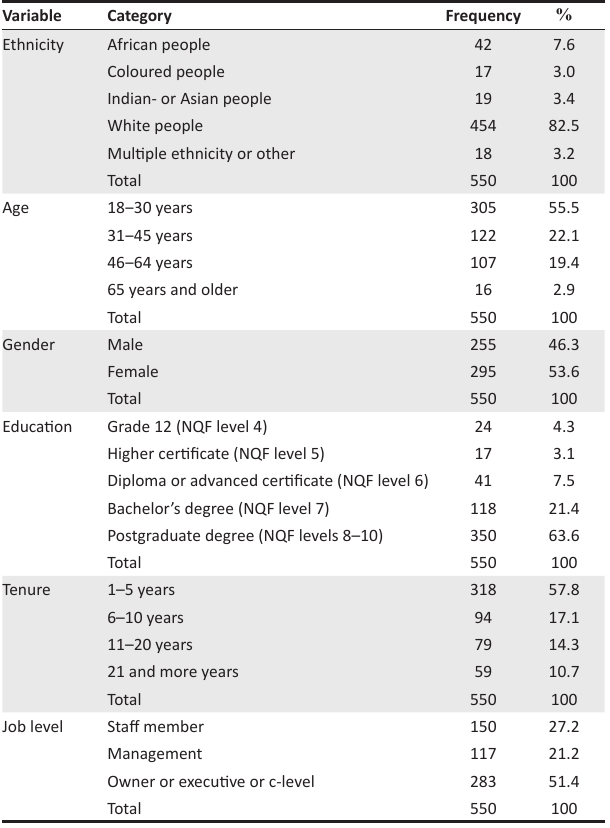
TABLE 2: Respondents’ biographical and demographic information.